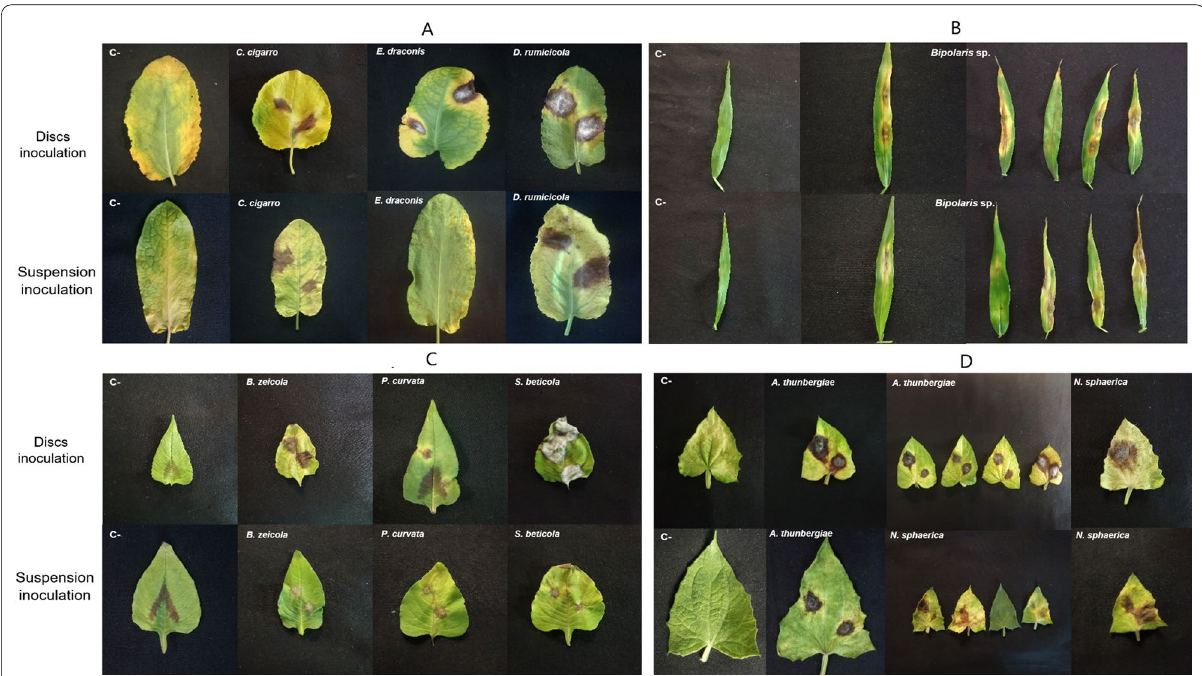
Fig. 2 Symptoms in detached leaves of weed hosts caused by fungal isolates tested, using two inoculation methodologies: mycelial discs and suspension of spores-mycelia fragments and their respective negative controls (C-). A Rumex crispus . B Digitaria horizontalis . C Persicaria nepalensis . D Thunbergia alata. Each figure is representative of its respective treatment. Each treatment consisted of four repetitions and three